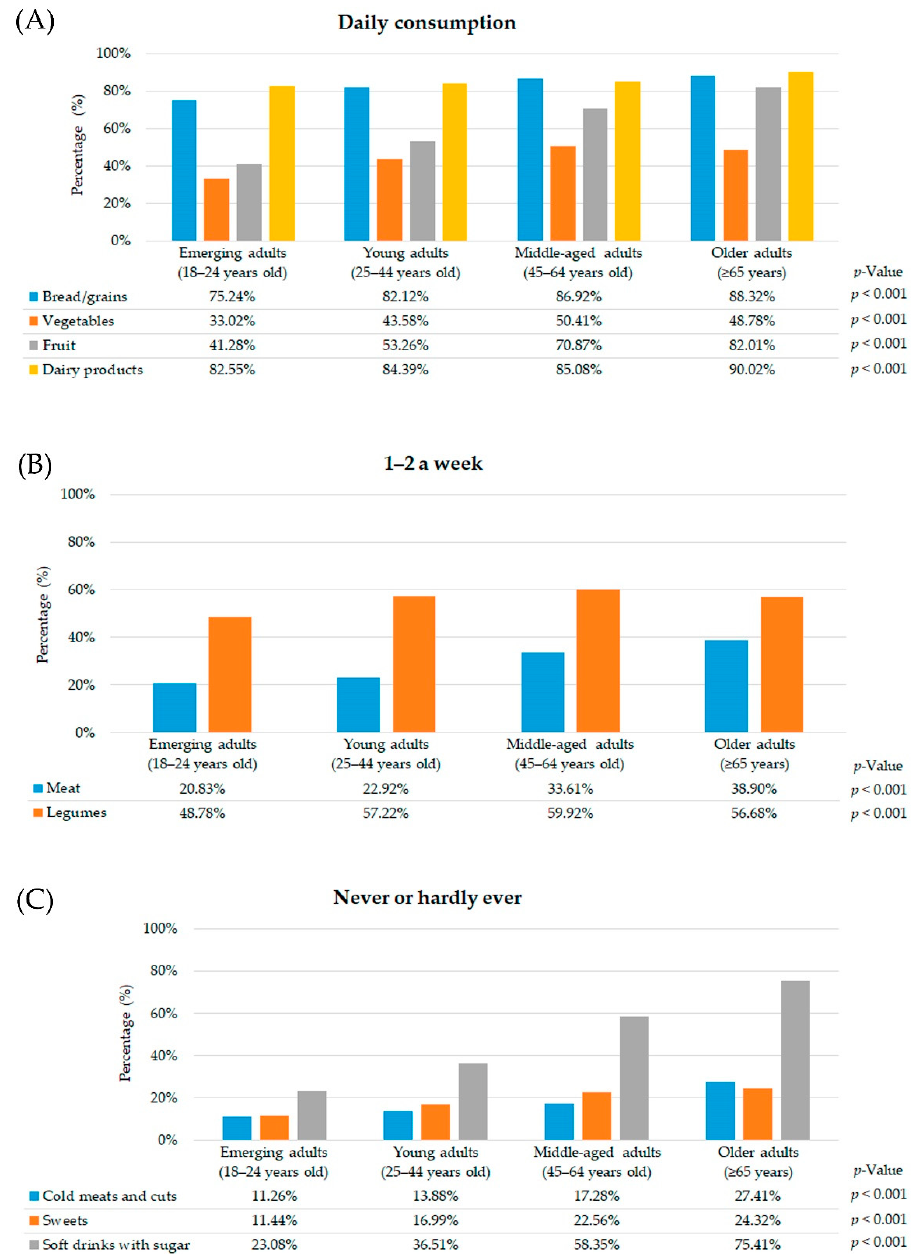
Figure 1. Frequency of food consumption according to age groups of participants with common mental disorders ( n = 12,545) (SNHS 2006, SNHS 2011/2012 and SNHS 2017) (( A ) for daily consumption, ( B ) for 1–2 a week, ( C ) for never or hardly ever).